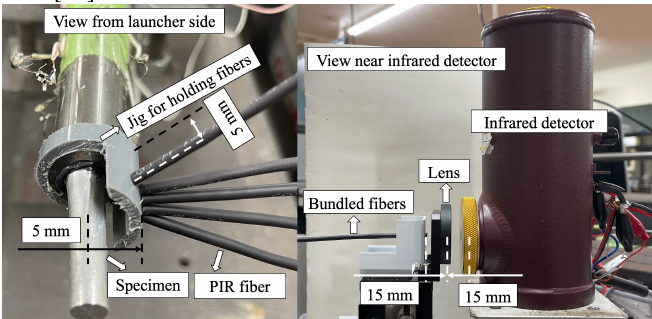
Fig. 2. A photo of the temperature measurement system using PIR